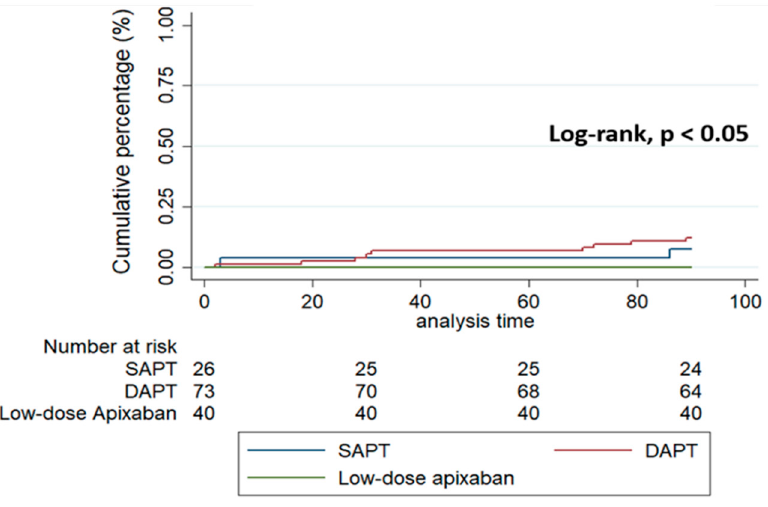
Figure 2. Kaplan-Meier curve of composite endpoint (efficacy and safety endpoints).